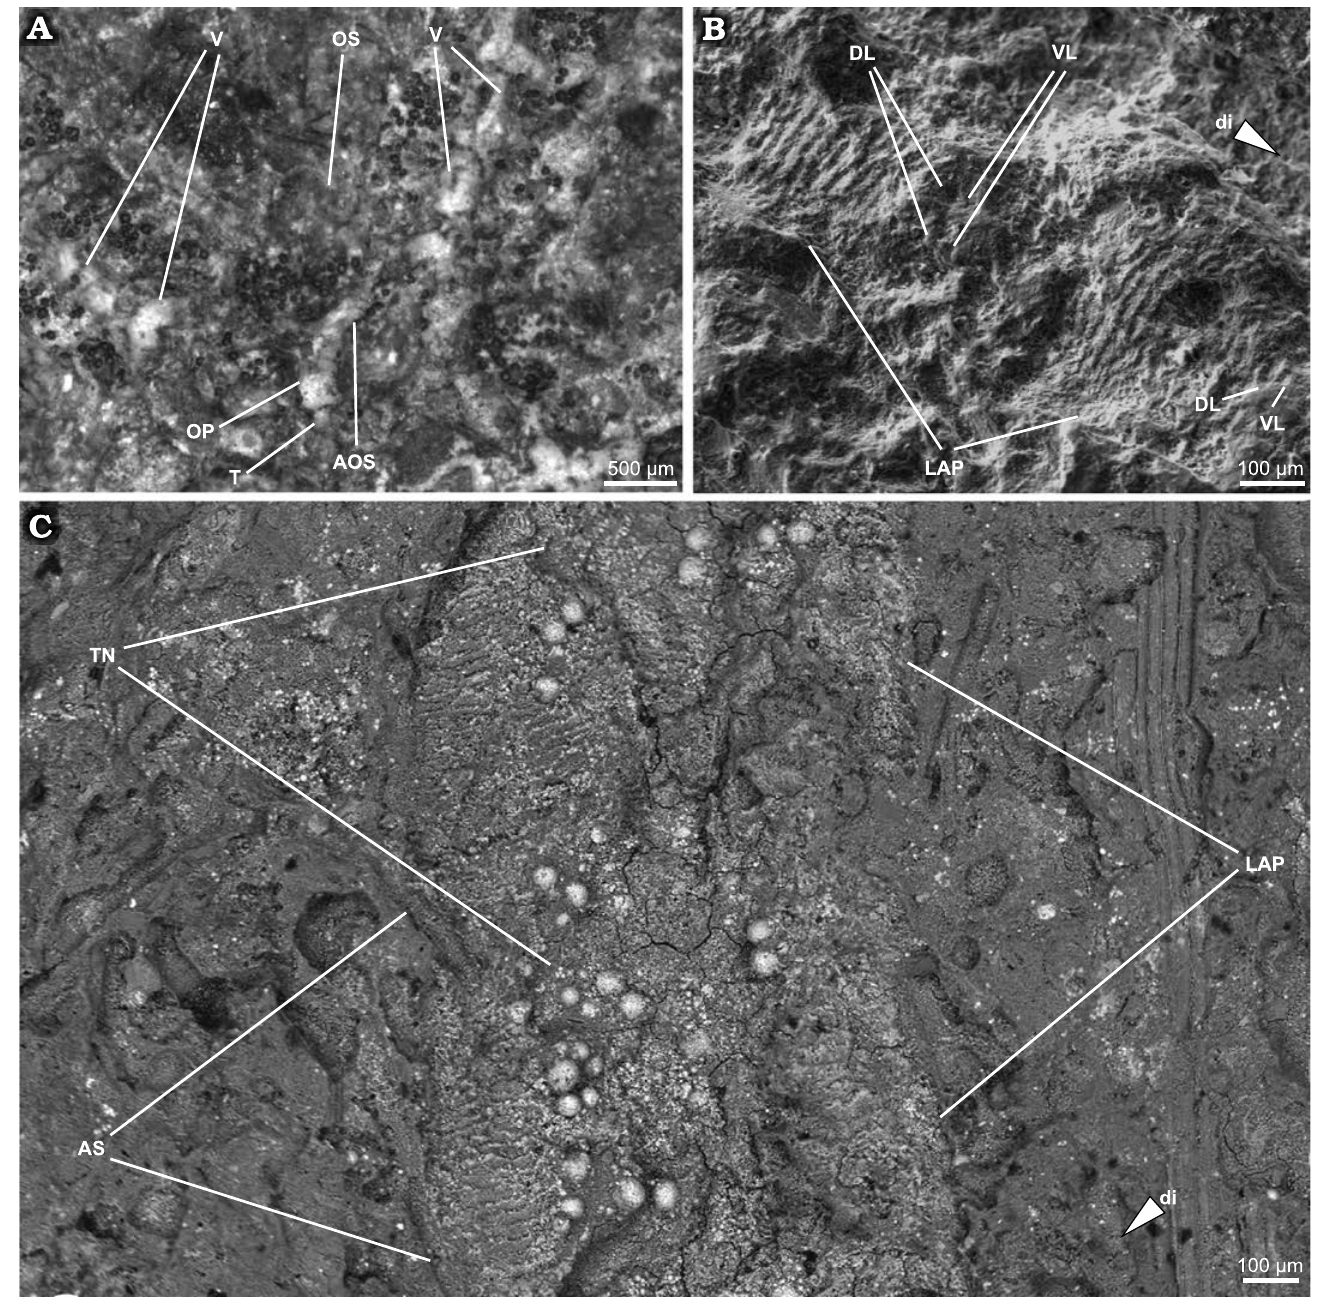
Fig. 5. Ophioleucid ophiuroid Sinosura sp. (MOZ-PI-5930) from the lower Pliensbachian of Sierra Chacaicó Formation, Arroyo Lapa locality, Neuquén, Argentina. A . Mouth skeleton of the studied specimen in ventral view, showing the vertebrae (V) of two arms, one oral shield (OS) proximally bordered by the adoral shields (AOS), a pair of oral plates (OP) and a ventralmost tooth (T). B . Detail of the lateral arm plates (LAP) showing the vertical striation and the spine articulations composed of dorsal (DL) and ventral lobes (VL), with an arrowing showing pointing to the distal (di) end of the arm. C . Detail of proximal arm segments in ventral view, showing the striated lateral arm plates (LAP), the arm spines (AS) and the tentacle notches (TN), with an arrowing showing pointing to the distal (di) end of the